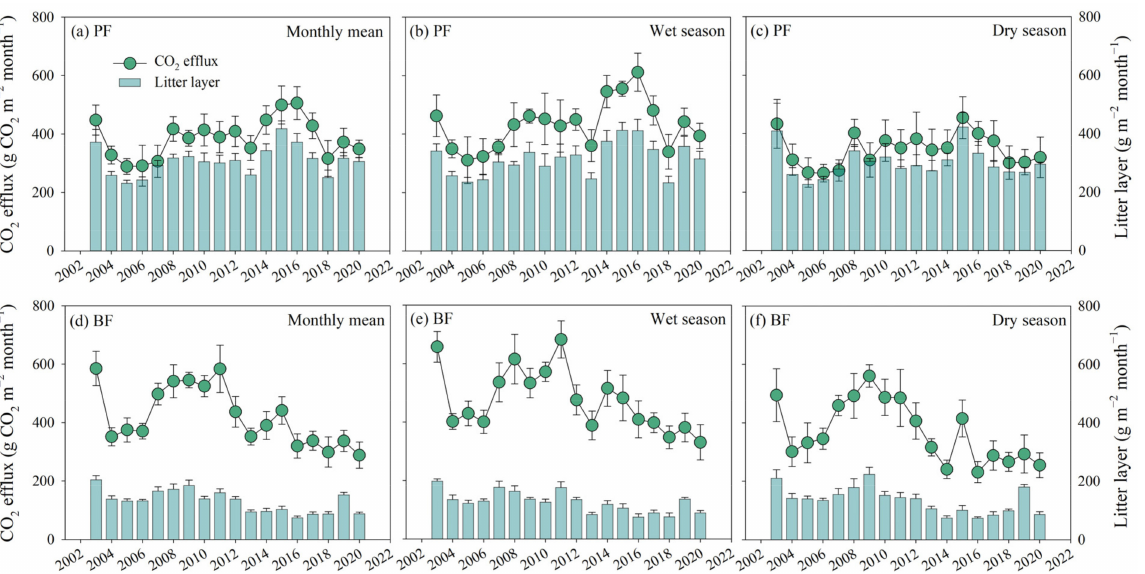
Figure 3. Monthly mean amount of surface litter layer and CO 2 efflux in PF (Masson pine forest) and BF (evergreen broadleaved forest) from 2003 to 2020. Numbers of observations for each data point are 12 for monthly mean and 6 for wet or dry season. Error bar represents one standard error.